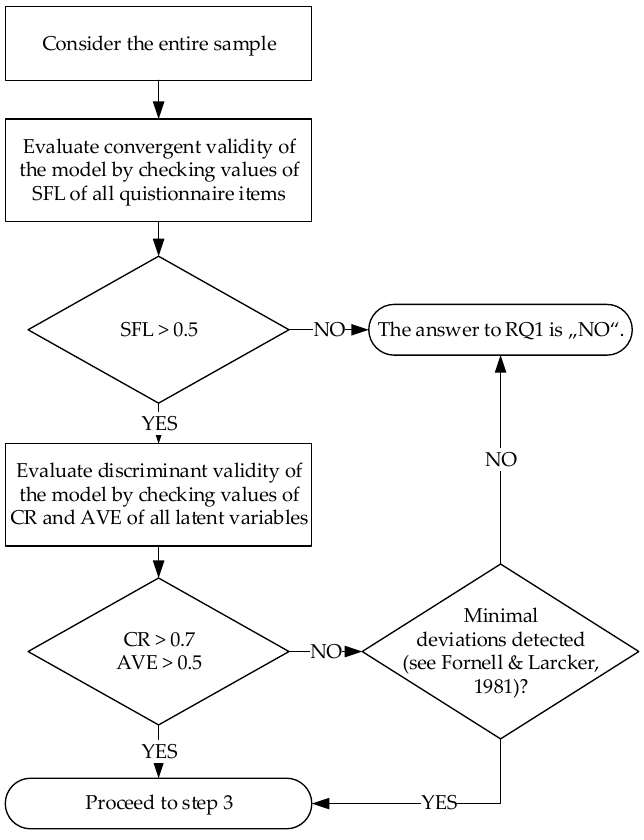
Figure 2. Step 2: Confirmatory Factor Analysis [60].